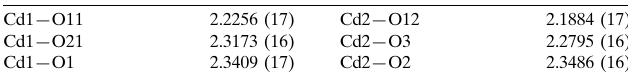
Selected geometric parameters (A˚ , (cid:2) ).